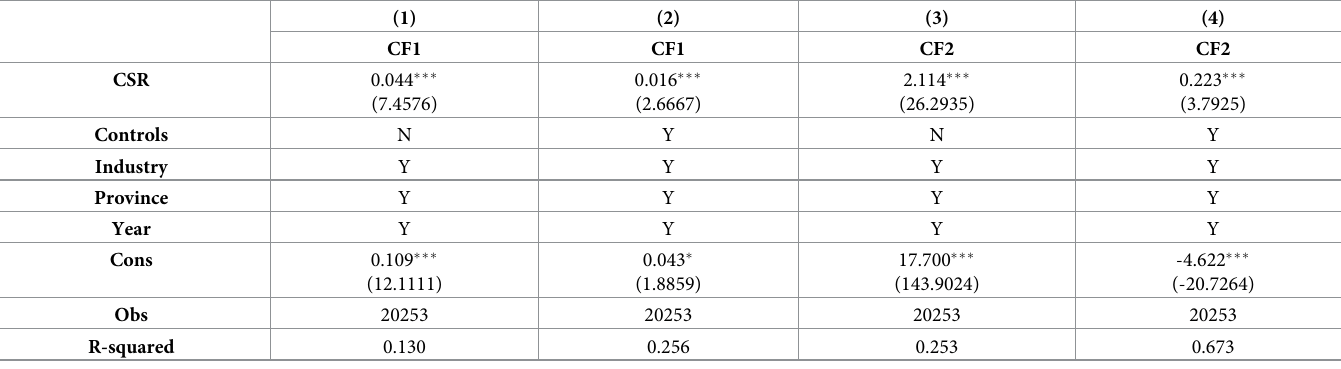
Table 3. Impact of corporate social responsibility on corporate financialization.